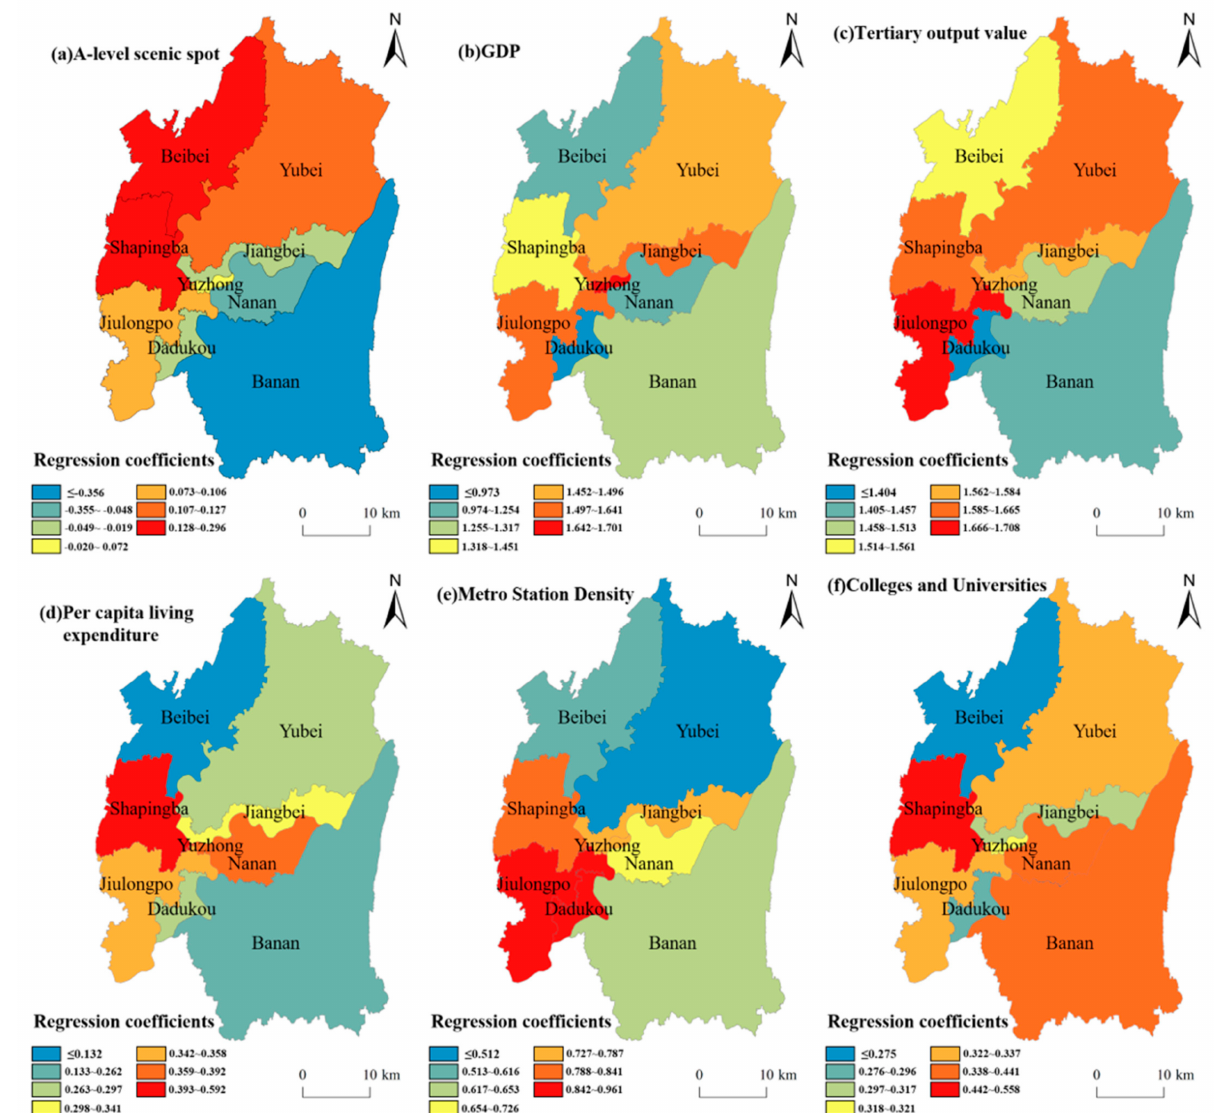
Figure 5. Spatial distribution of GWR model coefficients in the central urban area of